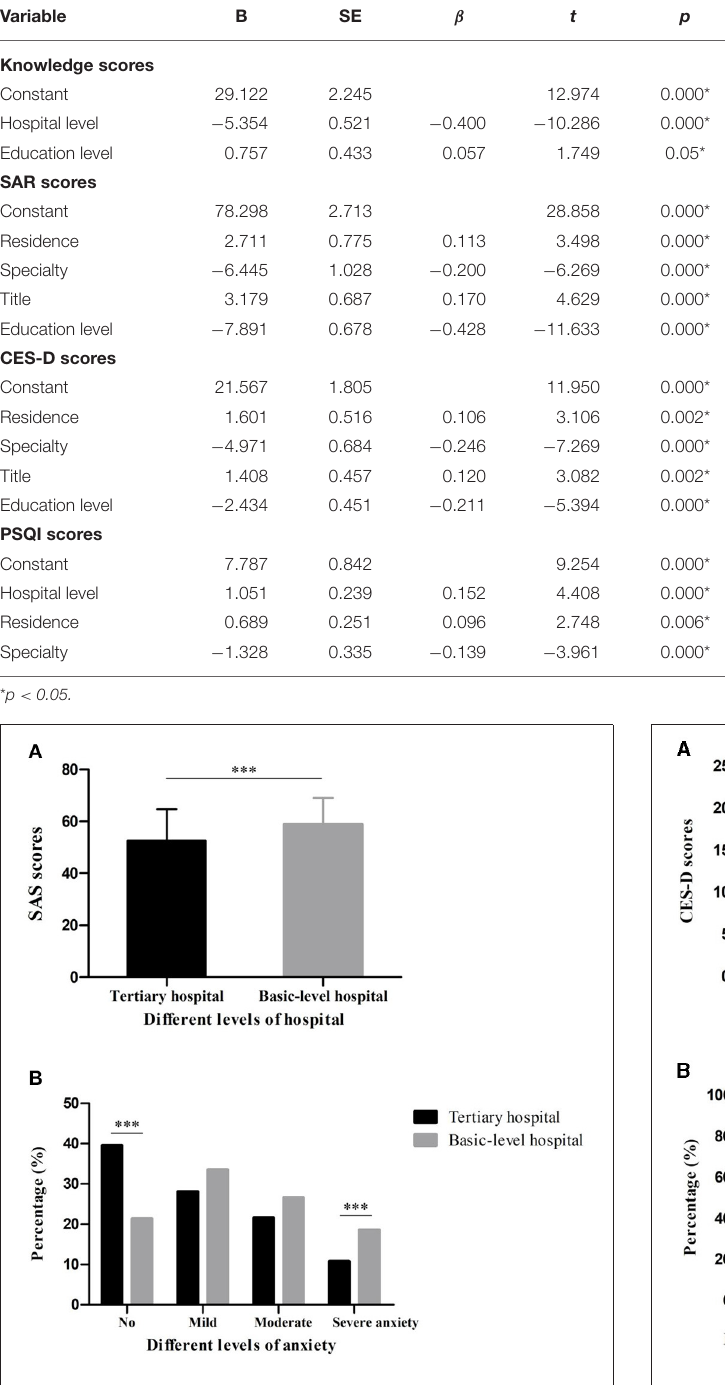
FIGURE 1 | SAS scores (A) and different levels of anxiety (B) of medical staff in tertiary hospitals and basic-level hospitals during the break of COVID-19 (*** p < 0.001).